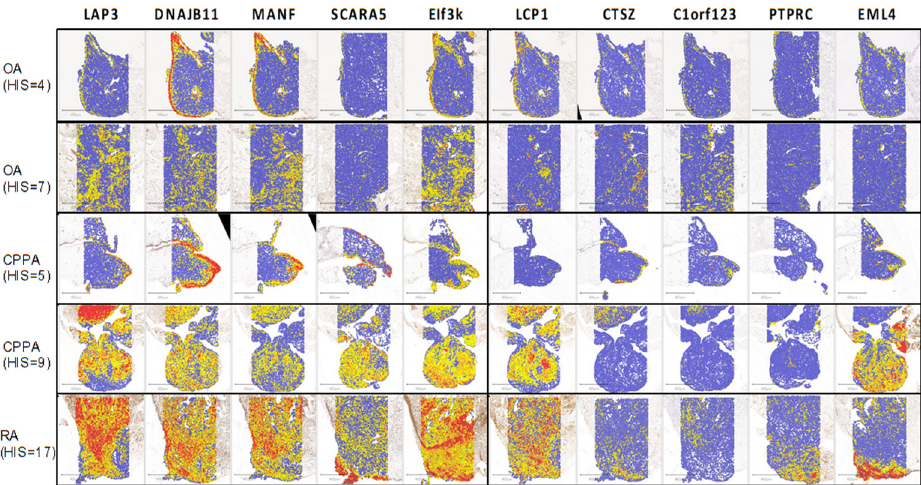
Figure 4. Immunohistochemistry illustration of the 10 highlighted proteins obtained with paraffin- embedded biopsies from synovial membrane of OA, CPPA and RA patients. The histological inflammatory scoring (HIS) is also associated with each biopsy. Highly positive cells have an OD > 0.6 (red spot), moderately positive 0.4 > OD > 0.6 (orange spot), weakly positive 0.2 > OD > 0.4 (yellow spot) and negative cells < 0.2 (blue spot). OA, osteoarthritis; CPPA, chronic pyrophosphate arthropathy; RA, rheumatoid arthritis.